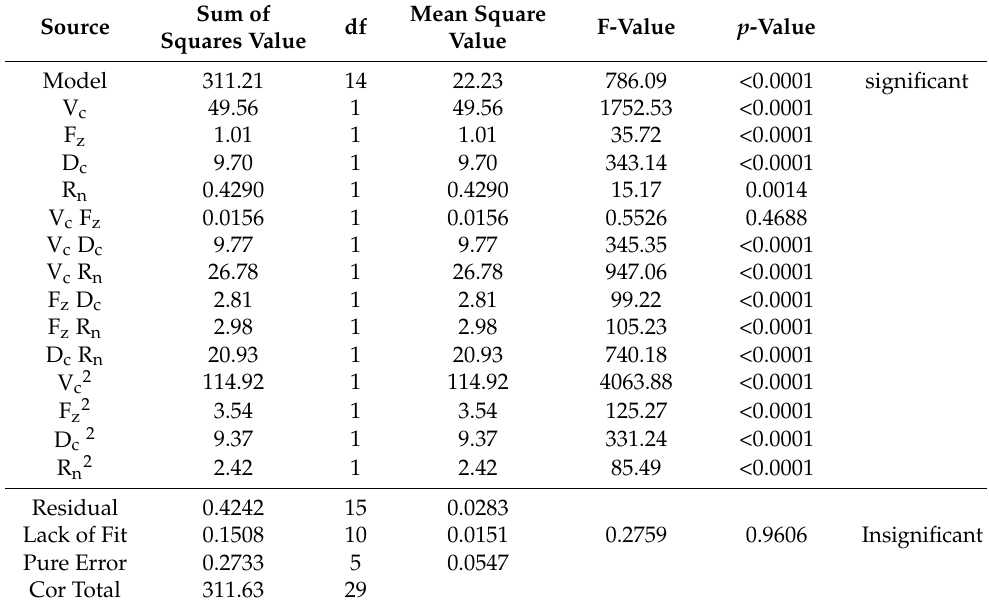
Table 3. ANOVA table for temperature rise prediction. Sum of Source Squares